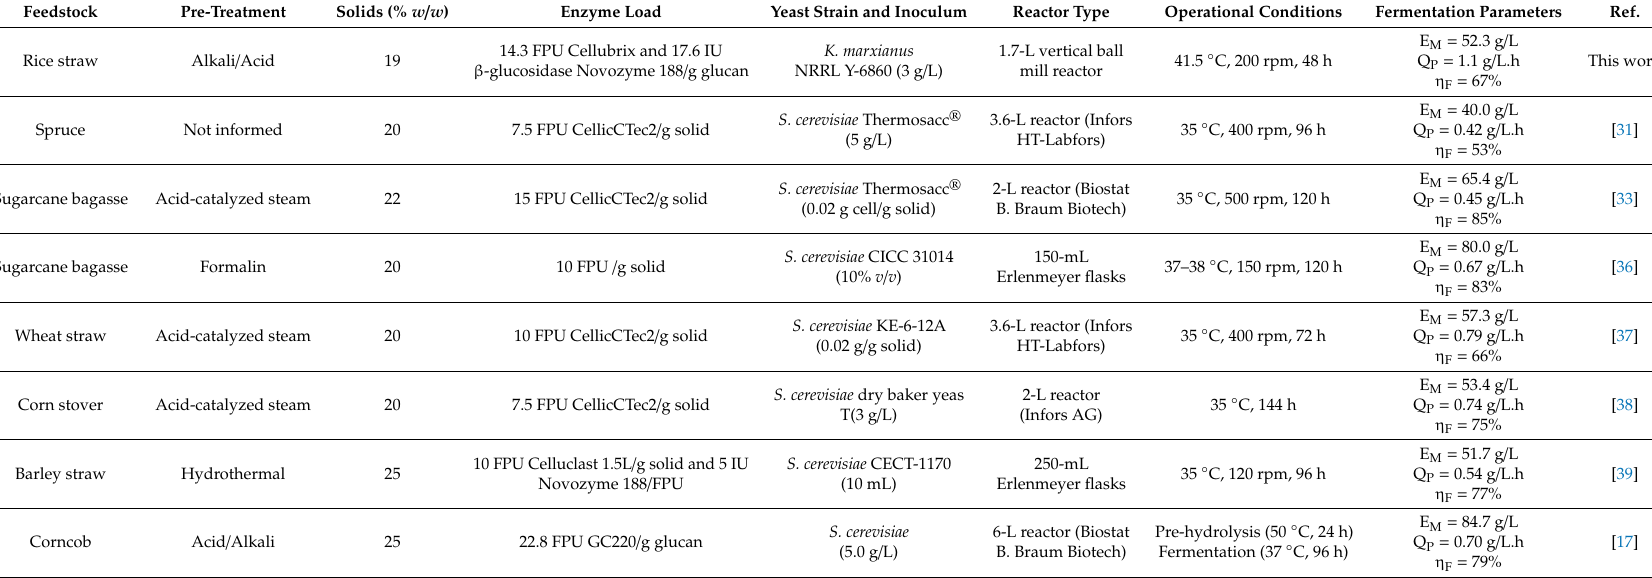
Table 9. Comparison of fed-batch simultaneous saccharification and fermentation experiments using di ff erent pre-treated feedstocks for ethanol production at high solid